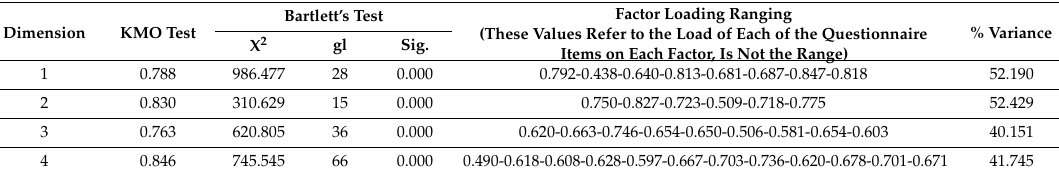
Table 3. The questionnaire’s construct